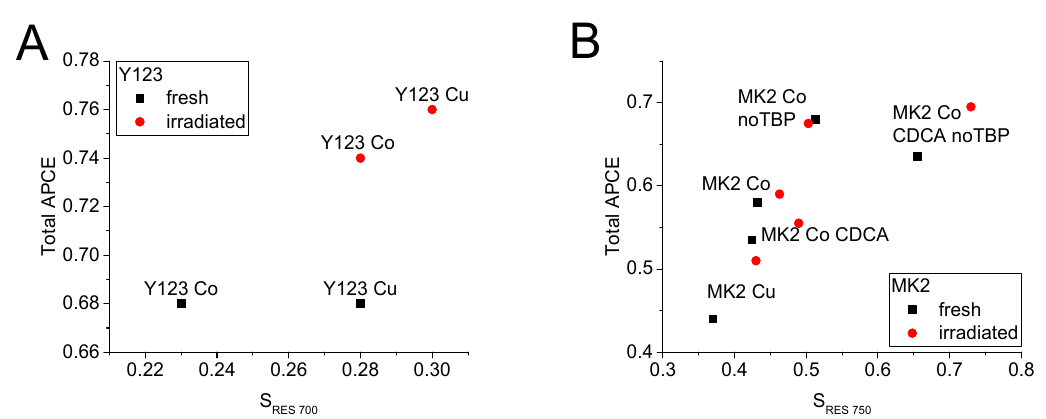
Figure 5. The correlations between Total APCE and recombinant kinetics residual signal at 700 nm for Y123 ( A ) and 750 nm for MK2 ( B ). The kinetics are given in Figure S8. Data points represent individual samples.